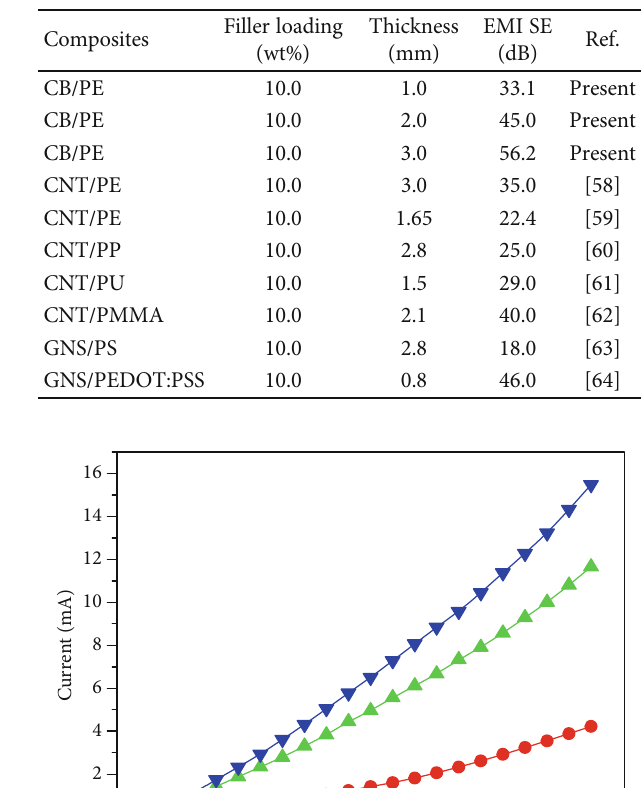
Table 4: EMI SE of the PEC10 composite and some other composites reported in the literature.